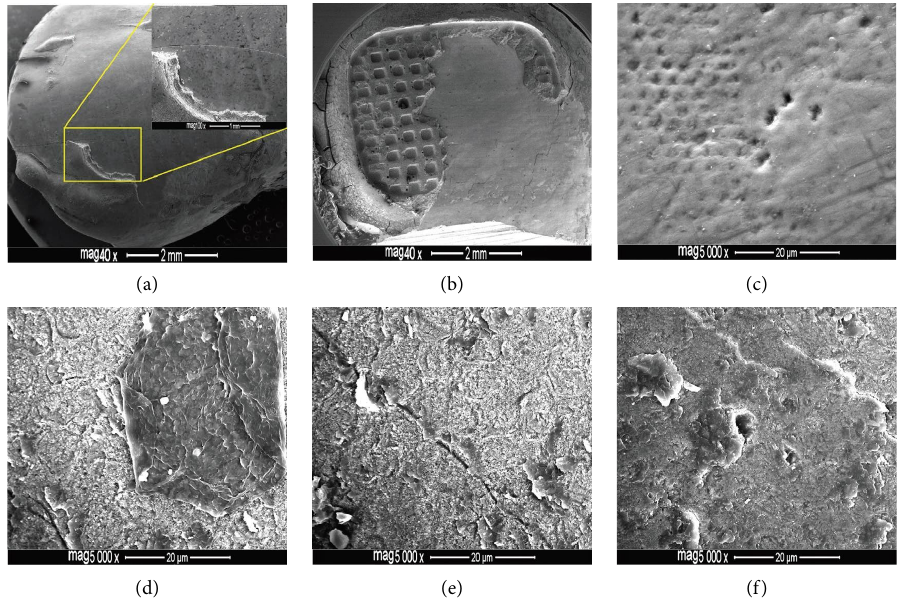
Figure 1: FE-SEM images of premolar buccal enamel surfaces etched with TSEP and debonded at 24h. Te etched teeth exhibited irregular, roughened enamel with abundant scratches, grooves, and cracks (a, e), adhesive residue (b, d), and open enamel micropores (c, f).